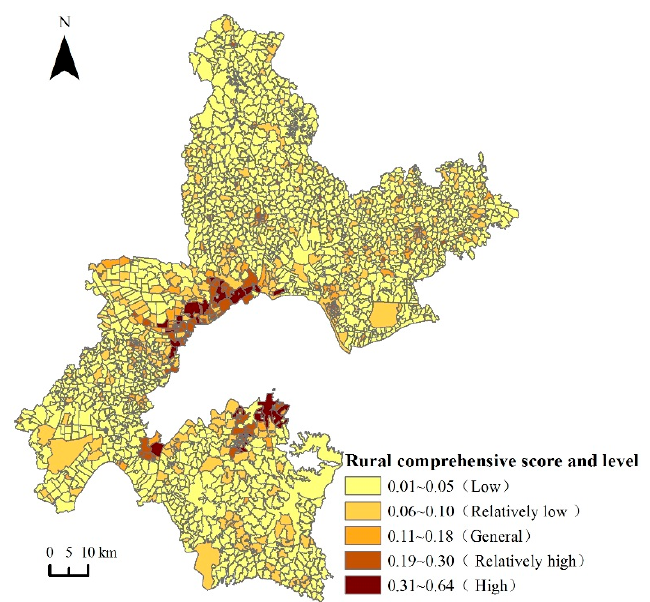
Figure 4. Spatial distribution of rural development level in administrative villages of Wuhan City’s new urban districts in 2017.